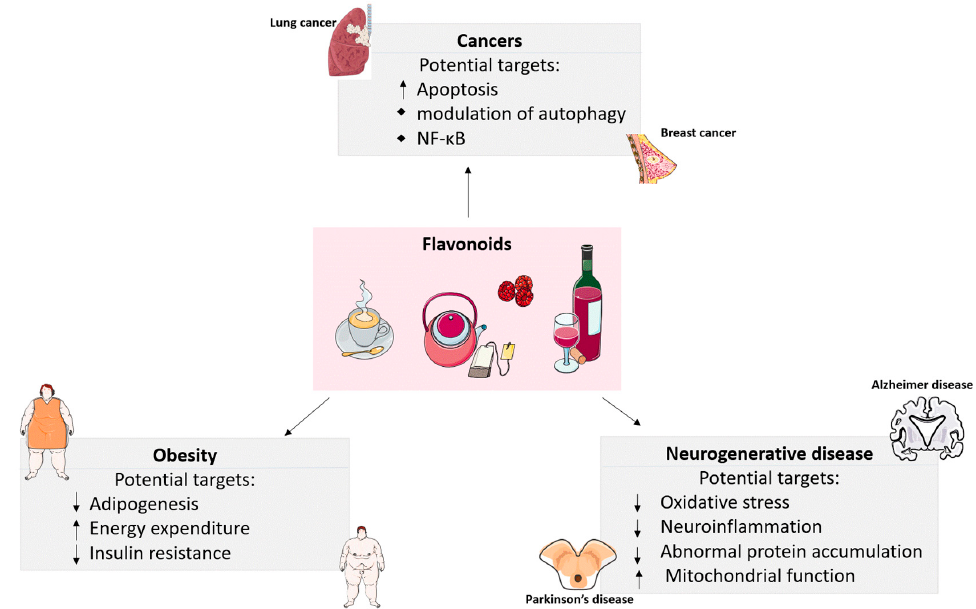
Figure 2. Potential mechanisms of flavonoids intervening in obesity, cancers, and neurogenerative diseases. Flavonoids can control body weight by suppressing adipogenesis, promoting energy expenditure, and alleviating insulin resistance; Flavonoids exert anti-cancer roles via apoptosis induction, autophagy network, and NF- κ B regulation; Flavonoids prevent neurogenerative diseases via alleviating oxidative stress, neuroinflammation, protein accumulation, and increasing mitochondrial function. ↓ , downregulate; ↑ , upregulate.